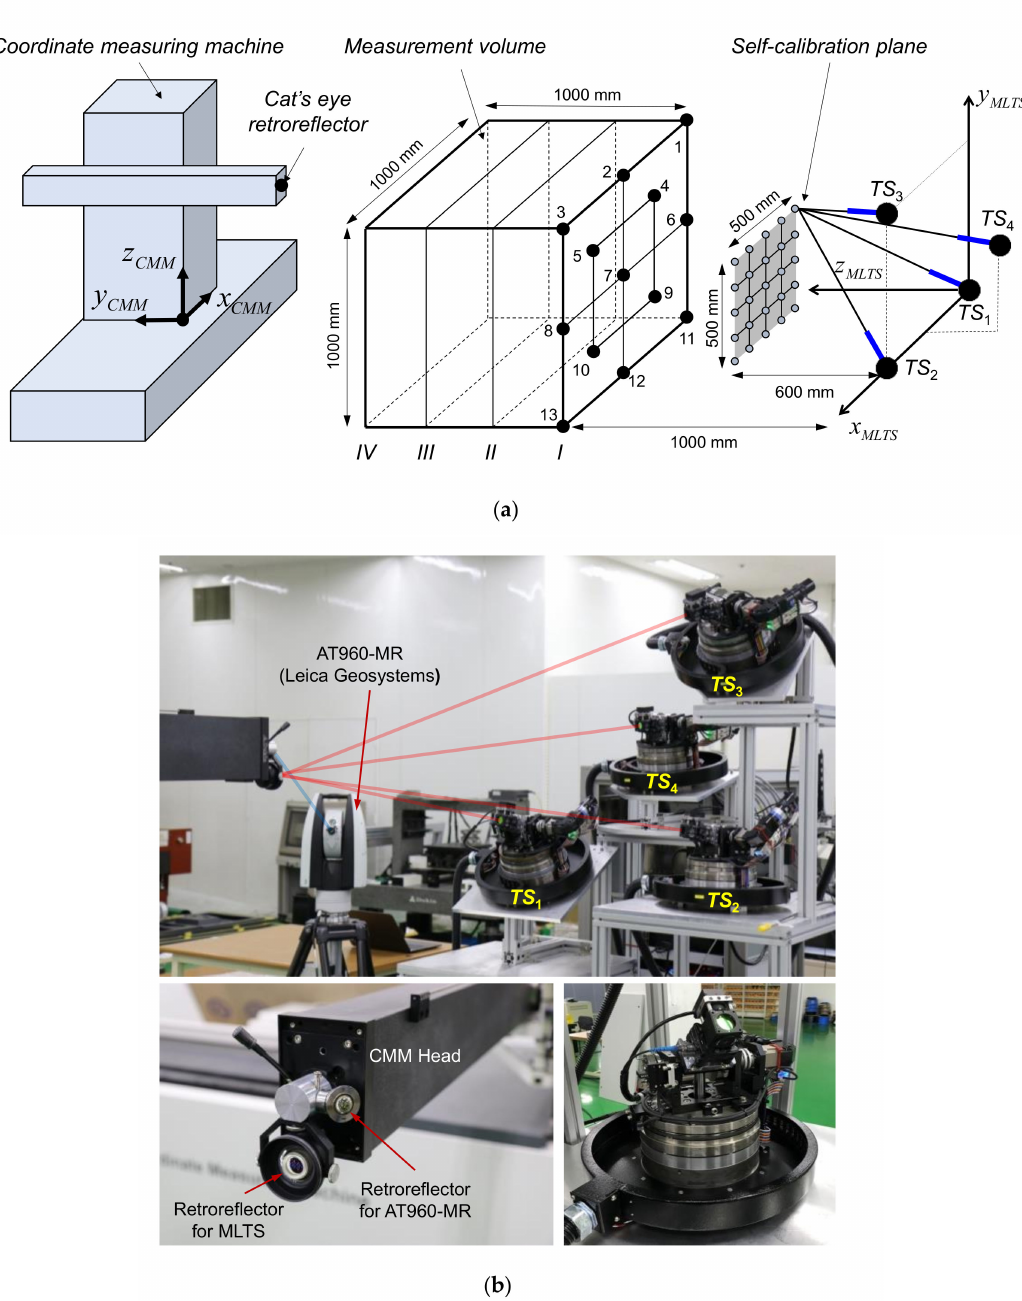
Figure 6. Experimental setup for self-calibration and 3D coordinate measurement: ( a ) Schematic of experimental setup; ( b ) Photograph of experimental